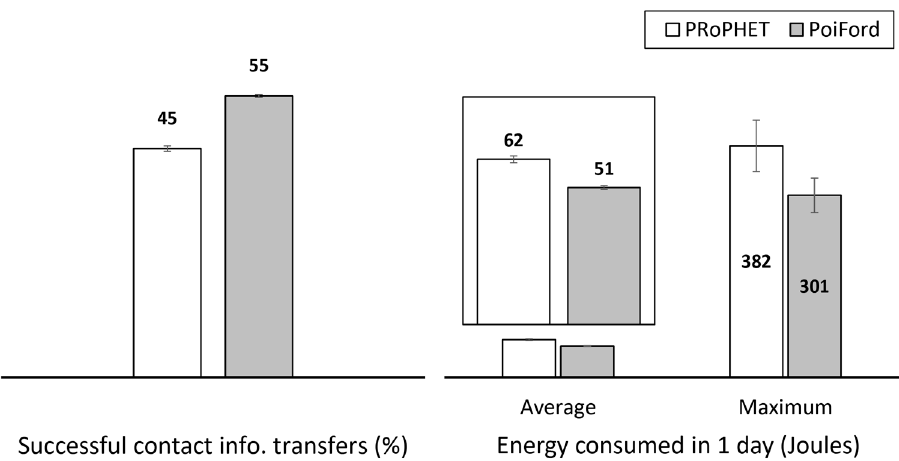
Figure 9. Percentage of contact information transfer attempts that were successful and energy consumed for transferring contact information in a day.